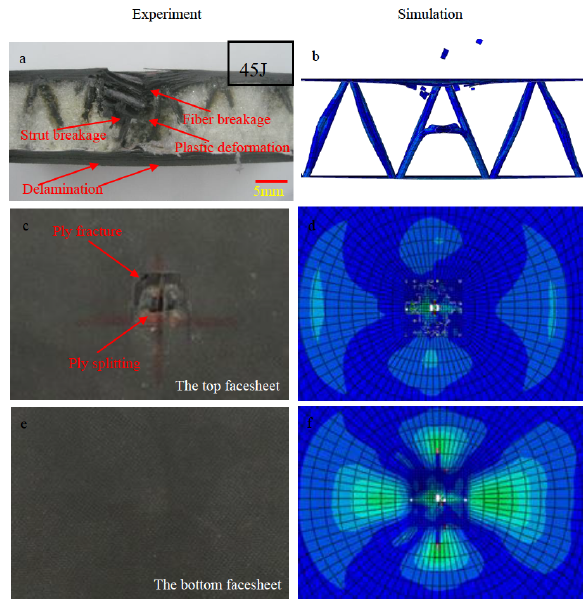
Figure 15: Impact damage of experimental and FEM simulation of foam sandwich composite stitched by 1mm diament strut at the impact energy of 45J.